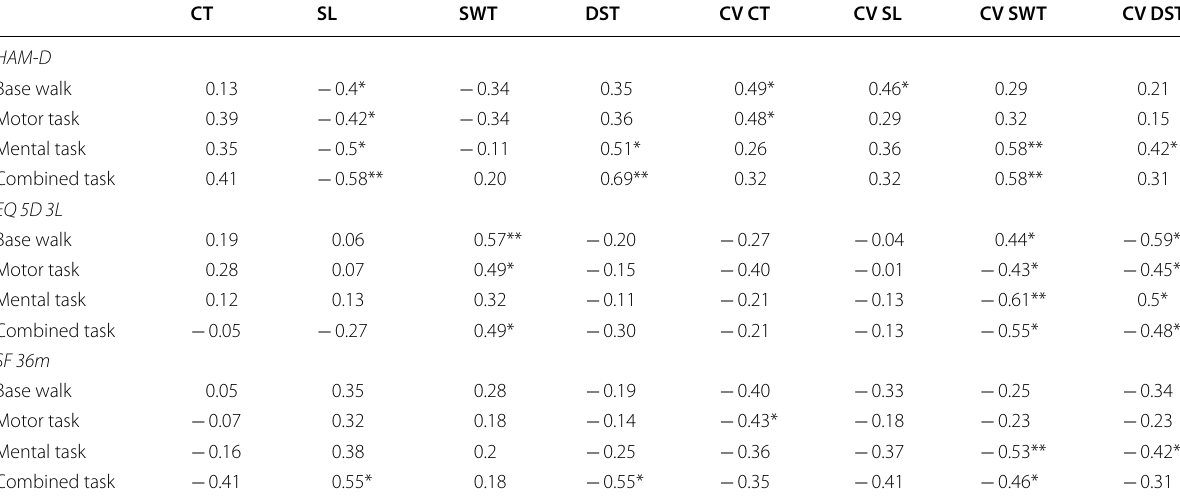
HAM-D: Hamilton Depression Rating Scale; EQ 5D 3L: Euroqol 5 dimensions 3-level version; SF 36m: The Health Survey Mental composite score. Correlations of other used assessment questionnaires and gait parameters were described in Result